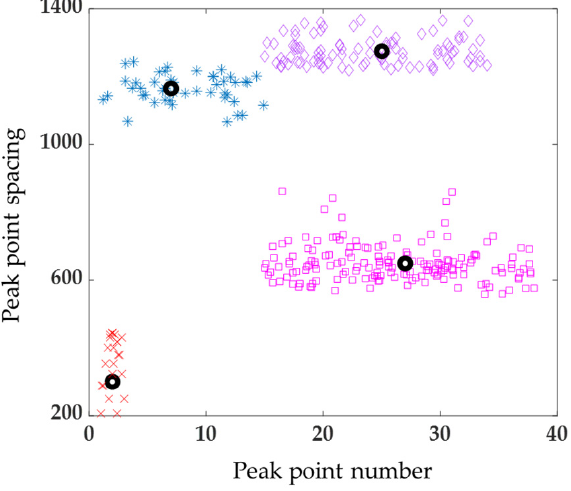
Red cross-symbols are redundant anchor points. Magenta squares are the category of spacing from S1 to S2. Blue asterisks and purple rhombi are the types of spacing from S2 to S1. There are redundant points in the diagram but no missing points.